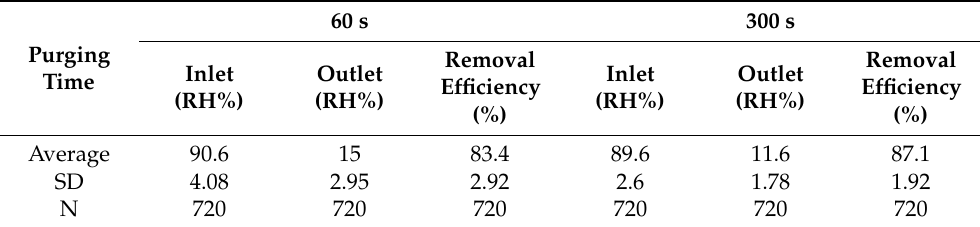
Figure 4. Comparison of VOC recovery rates according to various moisture pretreatment devices: ( a ) purging time: 60 s; ( b ) purging time: 300 s. (Note: lines indicate normal pressure and dots indicate abnormal pressure). Table 4. Effect of KPASS–Odor purging time on outlet